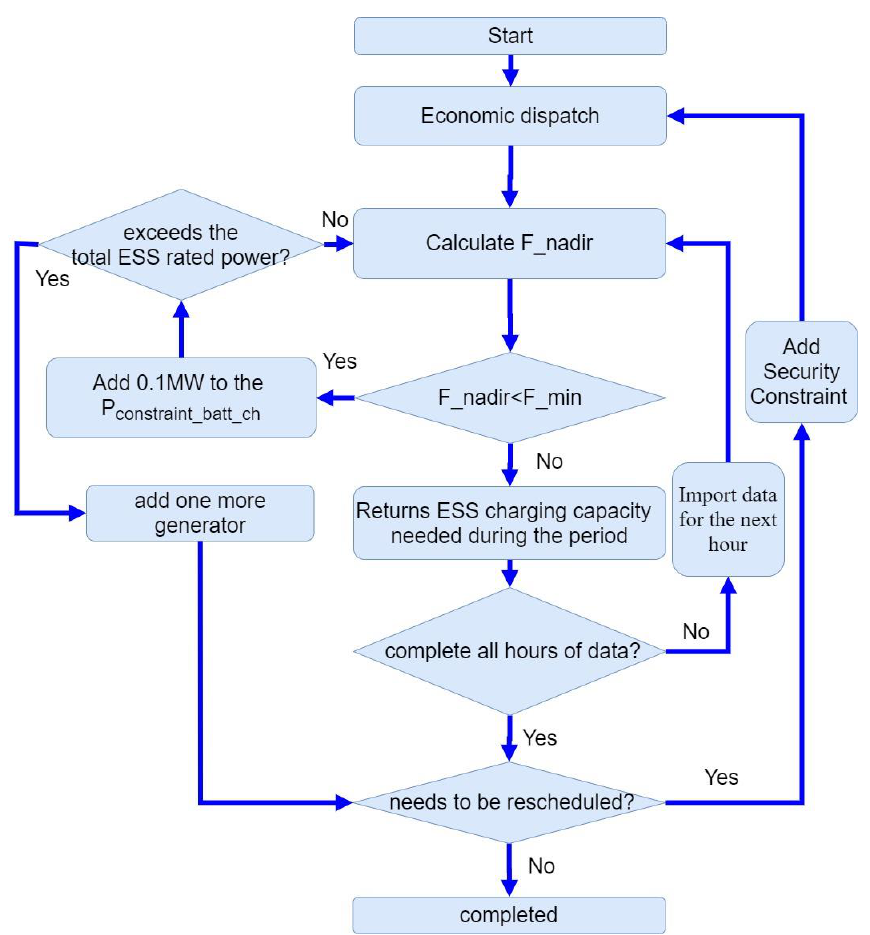
Figure 1. Flow chart.